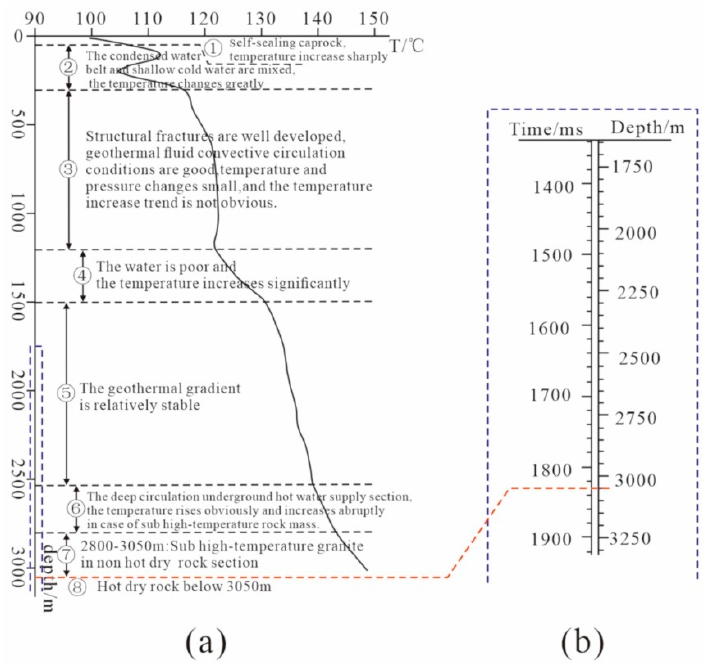
Figure 1. Geological background and distribution of the study area (adapt from Zhang Senqi, 2018) [27].